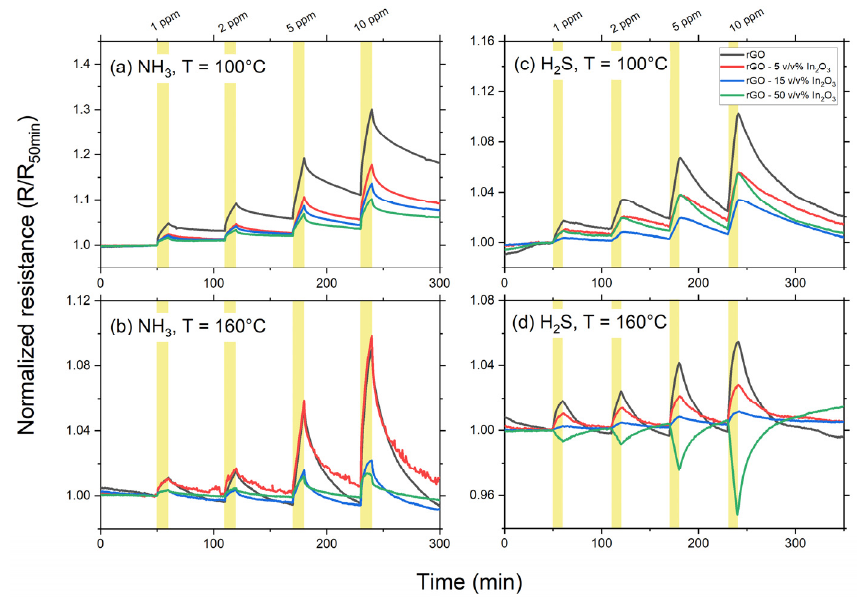
Figure 8. Dynamic response–recovery curves from sensors based on rGO-In 2 O 3 nanocomposites towards NH 3 at 100 °C ( a ) and 160 °C ( b ), and towards H 2 S at 100 °C ( c ) and 160 °C ( d ).